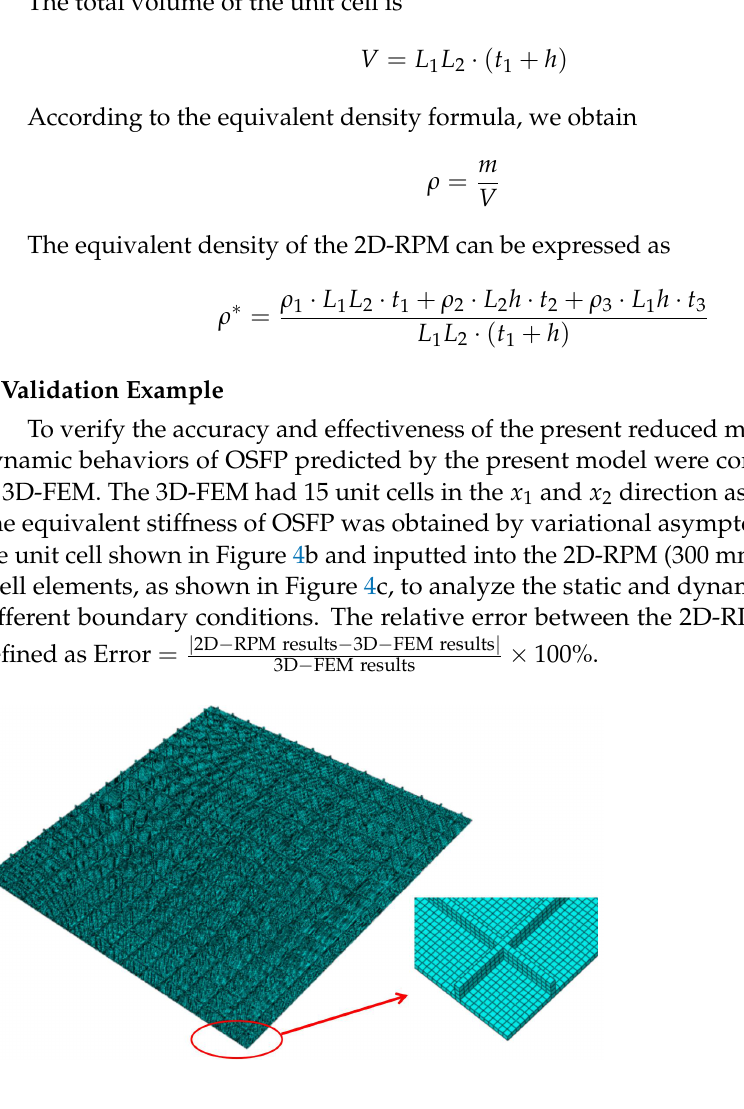
Figure 3. Meshing of 3D finite element model